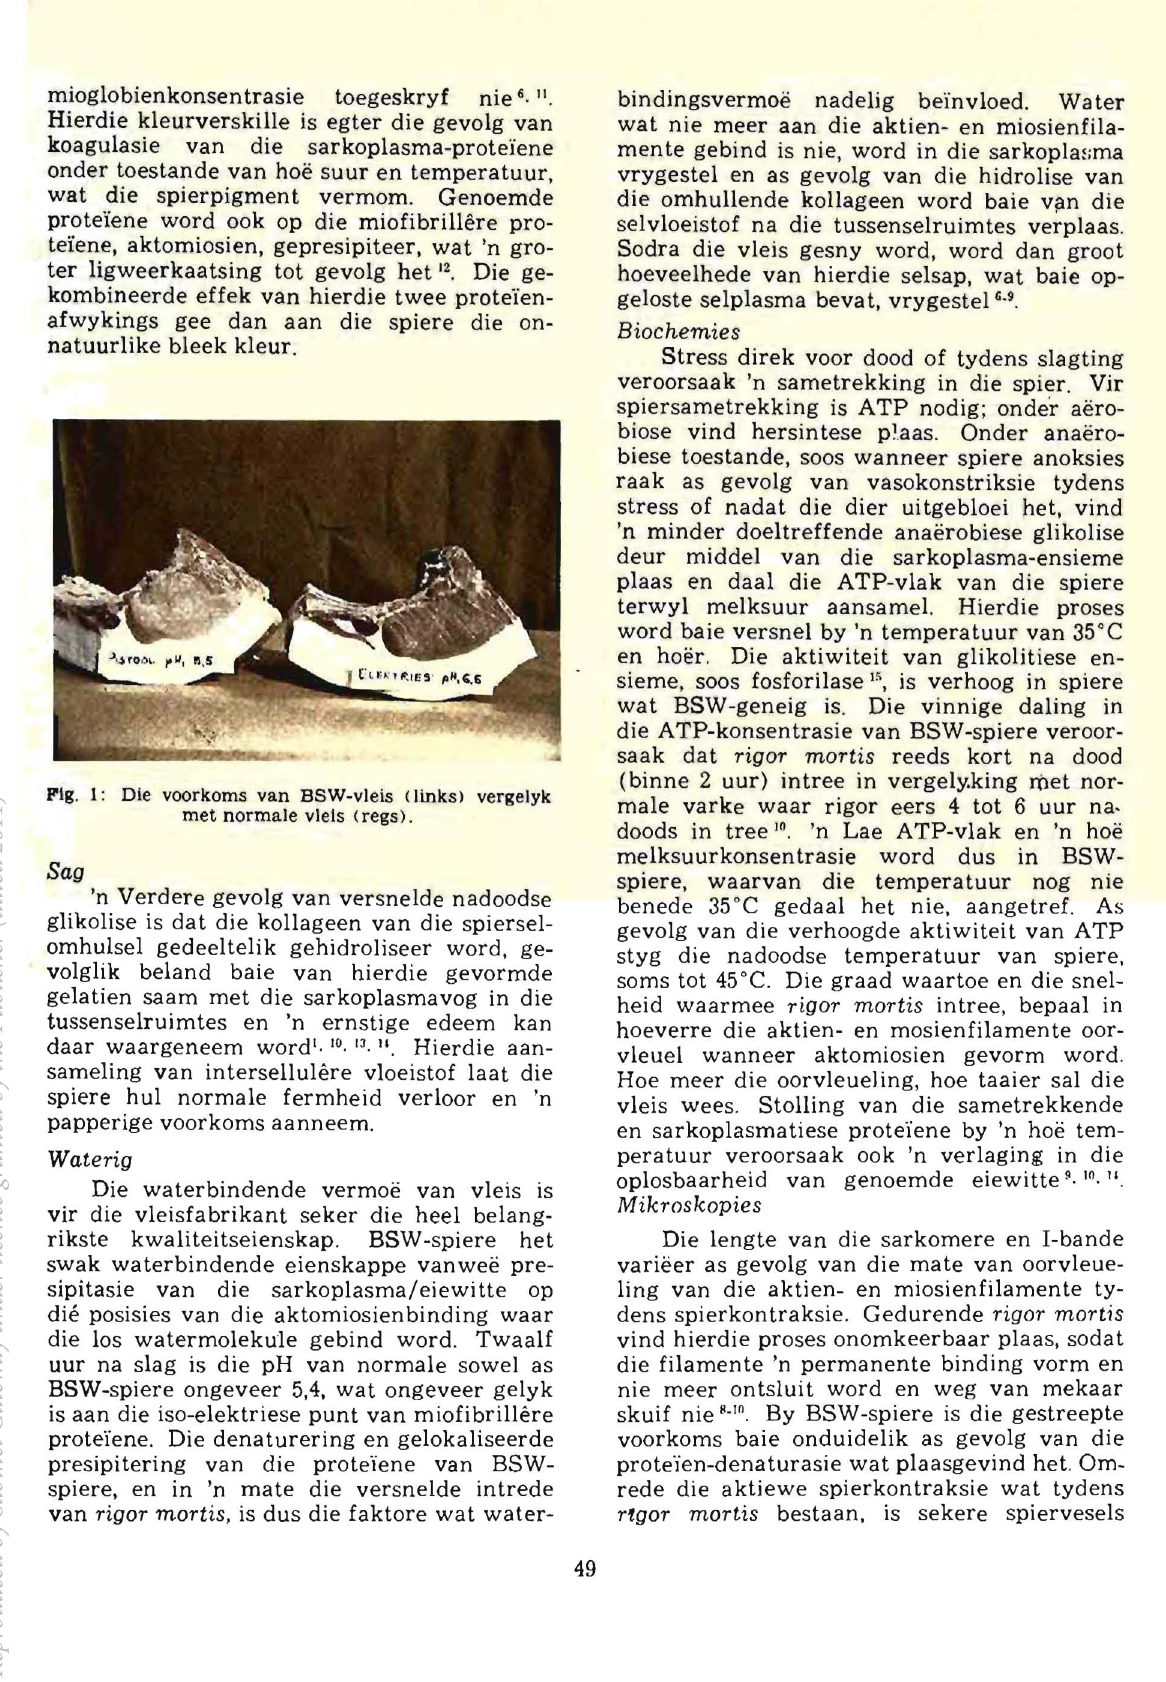
Fig. 1: Die voorkoms van BSW-vleis (links) vergelyk met norma Ie vie Is (regs).